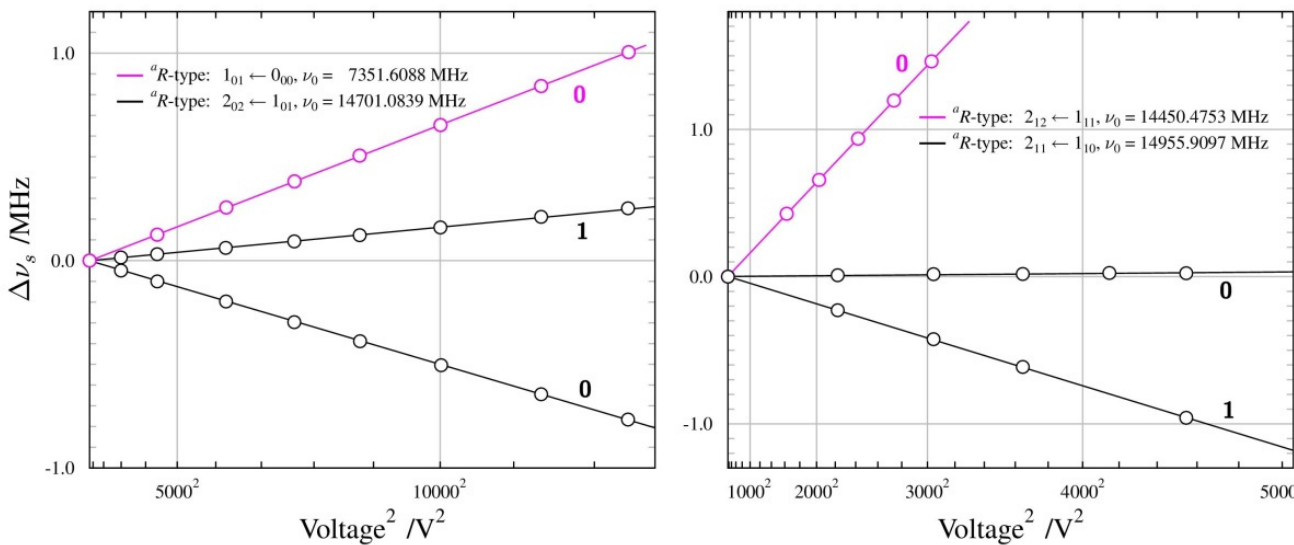
Figure 3. Summary of Stark measurements for the Aa conformer of n -propanol, plotted in the form of Stark frequency shift ∆ v s from zero-field transition frequency v 0 , as a function of the square of the applied voltage. Circles mark experimental points, while lines are drawn on the basis of the fitted dipole moment values. The calibrated Stark electrode separation is 26.97 cm, so that applied voltage of 10,000 V, for example, corresponds to electric field of 371 V/cm. All measured transitions are for the ∆ M = 0 selection rule and values of the M quantum number are indicated for each Stark lobe. The apparent linear frequency shift dependence of the measured Stark lobes demonstrates their second-order